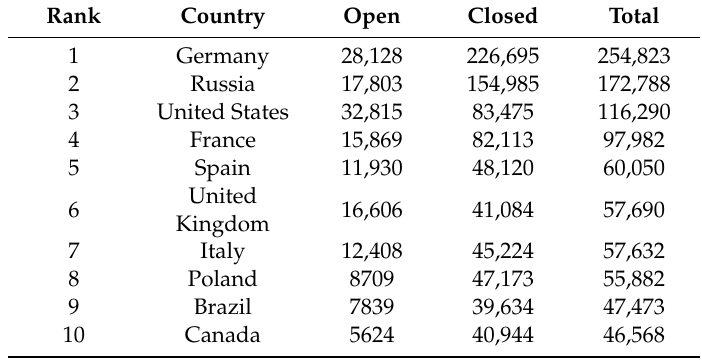
Table 4. Ranking of open/closed OSM Notes total number by country from April 2013 to April 2019.